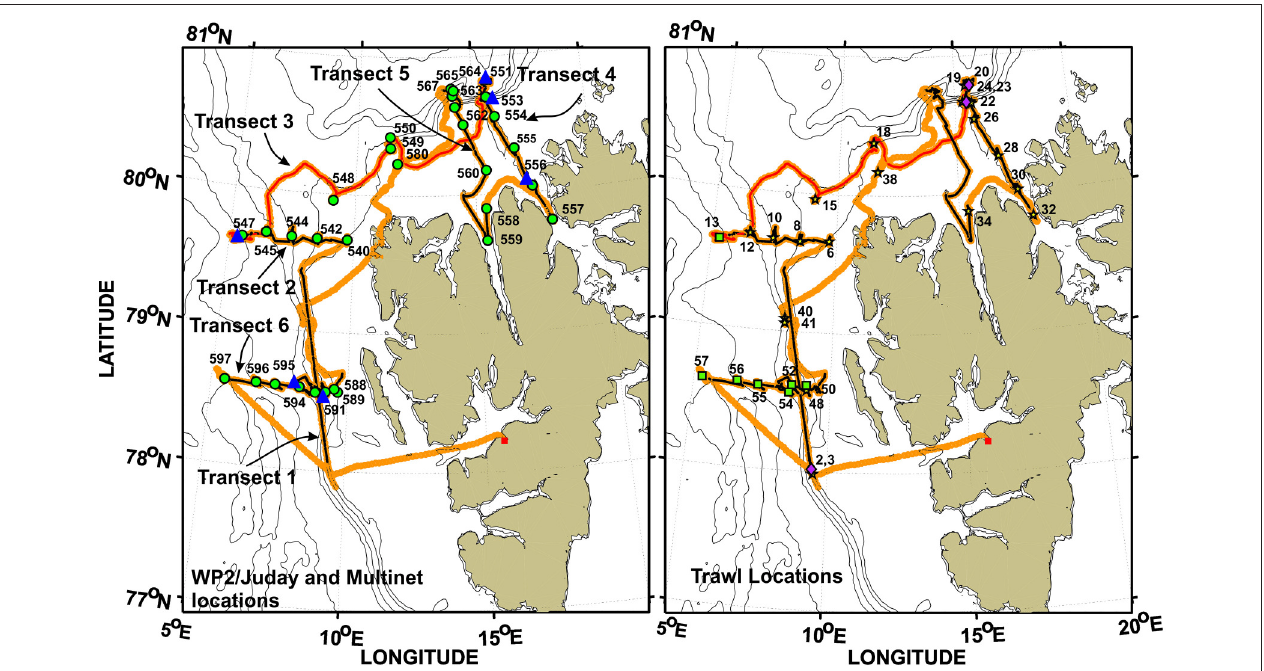
FIGURE 2 | The RV Helmer Hanssen cruise track in orange with the sections of the track where the 38kHz acoustic data were analyzed plotted in black, except for the Along Ice Edge transect that is red because it partly overlaps with the Fram Strait North and Hinlopen transects. Left: Station numbers and locations of the WP2/Juday net (green filled circles) and Multinet tows (blue triangles). Right: Station numbers and locations where the mid-water trawls were taken (cf. Tables 5 , 6 ). Harstad trawls are designated by stars, Macroplankton trawls by diamonds, and Åkra trawls by squares. Transect 1, Along Shelf Break; Transect 2, Fram Strait